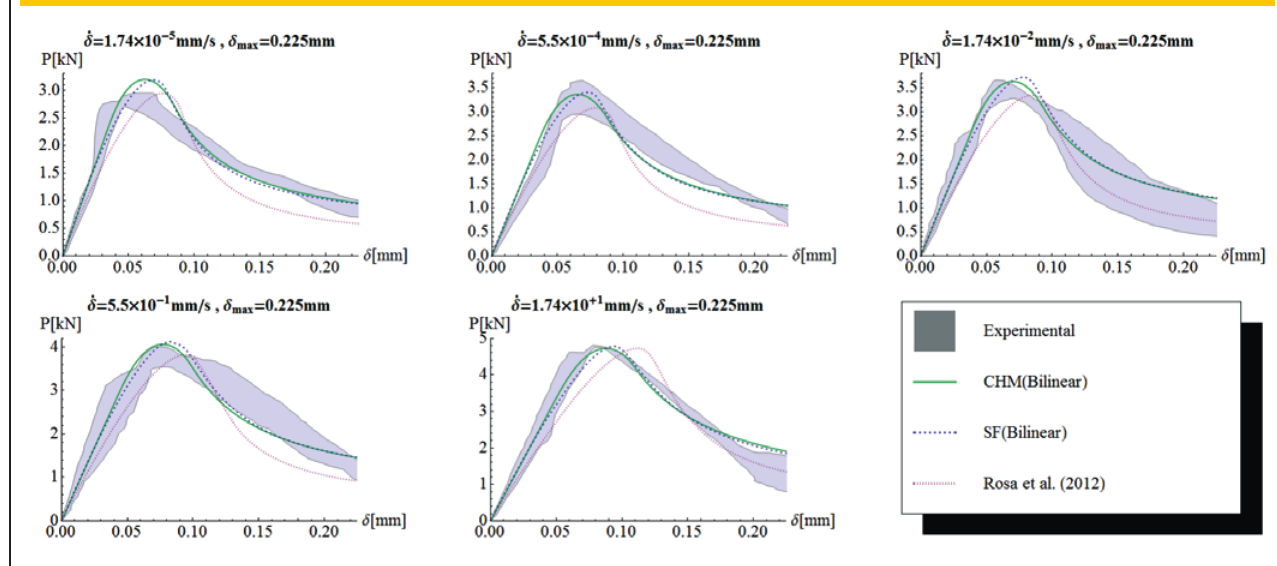
curve to the range from 0 to 0.225 mm using the bilinear curve [1]P-